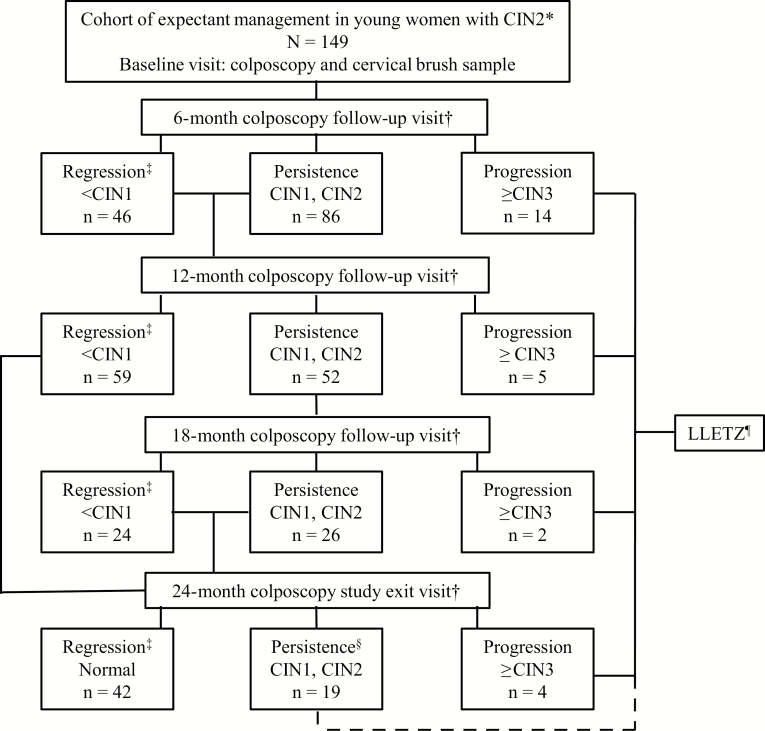
Flowchart of the expectant management of the cervical intraepithelial neoplasia (CIN) grade 2 study. The study started in the colposcopy clinic of Helsinki University Hospital, Finland, in September 2013, and is ongoing. The flowchart shows the numbers for the first 149 (age 18–30 years) women included in the current analyses who had a minimum of 2 follow-up visits completed as of November 2017. Women with follow-up diagnoses CIN grade 1 (<CIN1) were categorized as regression, women with CIN1 and/or CIN2 were categorized as persistence, and women with CIN grade 3 or worse (≥CIN3) were categorized as progression. Women with histological ≥CIN3 were treated with loop electrosurgical excision procedure, as were all women with a diagnosis (histological or colposcopic) of CIN1 or CIN2 after 2 years. Abbreviations: CIN, cervical intraepithelial neoplasia; LEEP, loop electrosurgical excision procedure; LLETZ, large loop excision of the transformation zone.